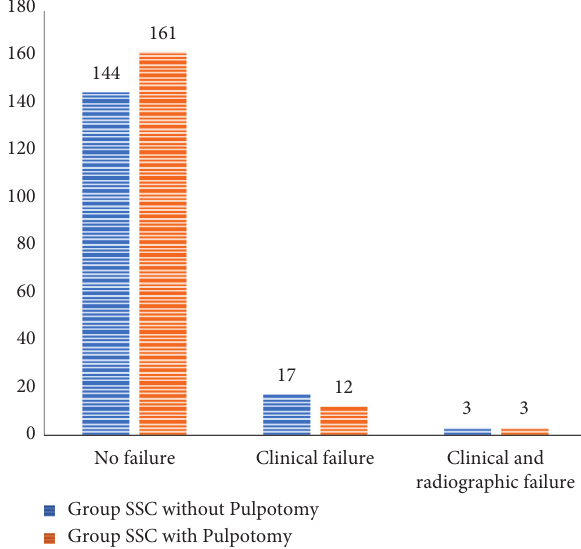
Figure 3: Types of failure in the two